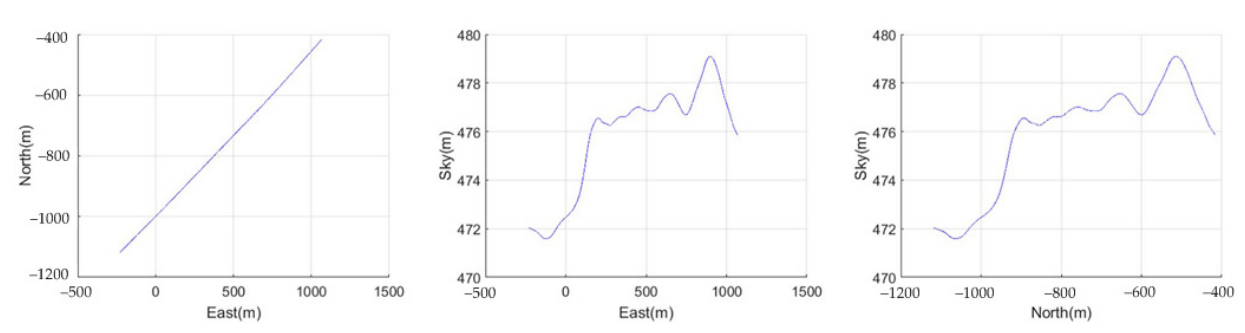
Figure 15. Flight trajectory of the radar platform.